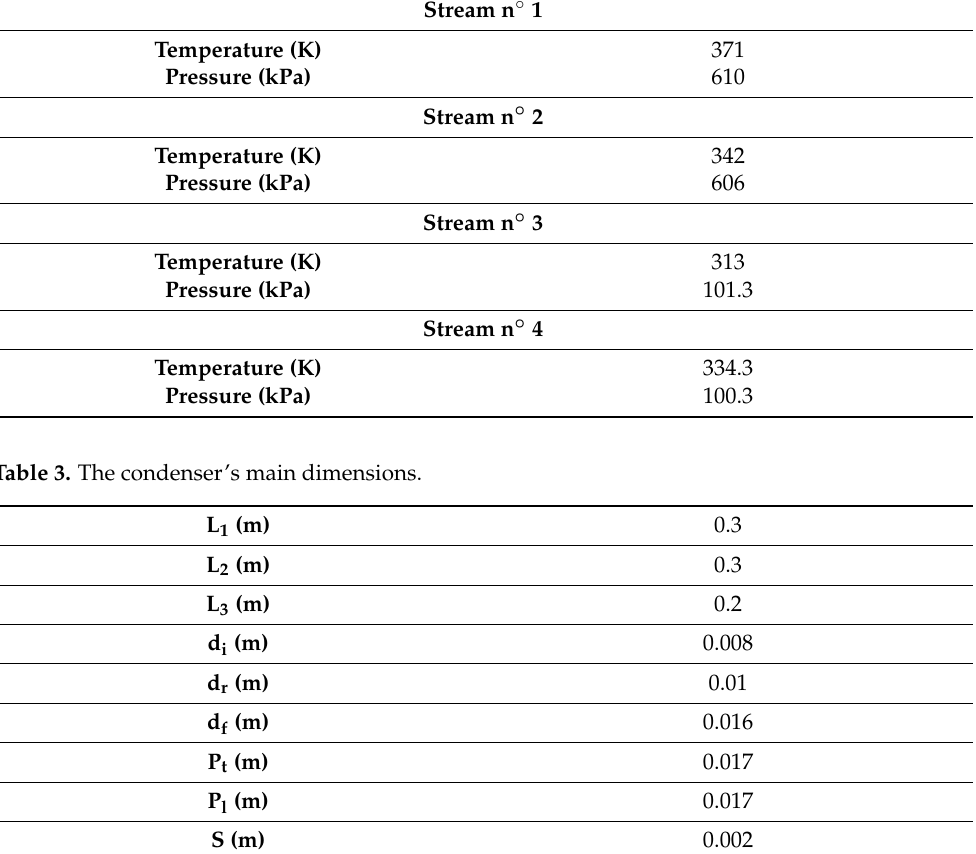
Table 2. Condenser Streams.